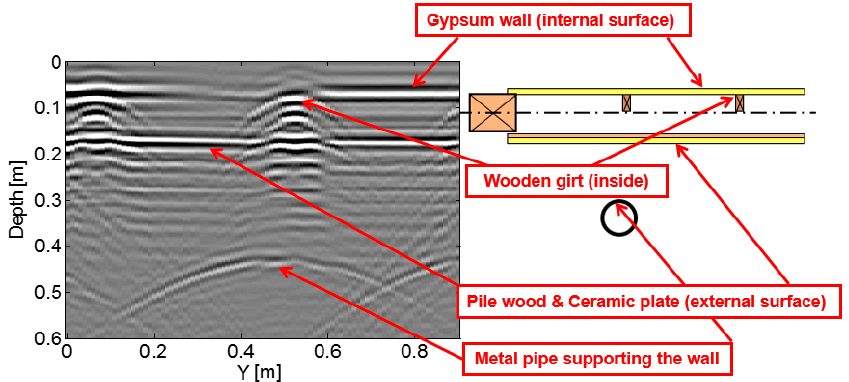
Figure 6. Raw radar profile acquired along the 1D survey line on the Type I wall specimen (Figure 1a and Figure